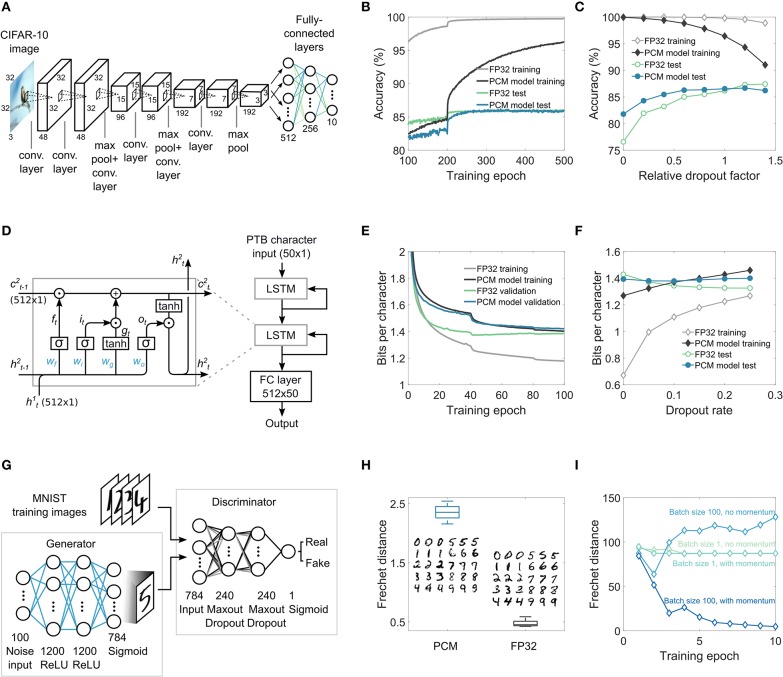
MCA training validation on complex networks. (A) Convolutional neural network for image classification on CIFAR-10 dataset used for MCA training simulations. The two convolution layers followed by maxpooling and dropout are repeated thrice, and are followed by three fully-connected layers. (B) The classification performance on the training and the test datasets during training. It can be seen that the test accuracy corresponding to MCA-based training eventually exceeds that from the high-precision (FP32) training. (C) The maximal training and test accuracies obtained as a function of the dropout rates. In the absence of dropout, MCA-based training significantly outperforms FP32-based training. (D) The LSTM network used for MCA training simulations. Two LSTM cells with 512 hidden units followed by a fully-connected (FC) layer are used. (E) The BPC as a function of the epoch number on training and validation sets shows that after 100 epochs, the validation BPC is comparable between the MCA and FP32 approaches. The network uses a dropout rate of 0.15 between non-recurring connections. (F) The best BPC obtained after training as a function of the dropout rate indicates that without any dropout, MCA-based training delivers better test performance (lower BPC) than FP32 training. (G) The GAN network used for MCA training simulations. The generator and discriminator networks are fully-connected. The discriminator and the generator are trained intermittently using real images from the MNIST dataset and the generated images from the generator. (H) The Frechet distance obtained from MCA training and the generated images are compared to that obtained from the FP32 training. (I) The performance measured in terms of the Frechet distance as a function of the number of epochs obtained for different mini-batch sizes and optimizers for FP32 training. To obtain convergence, mini-batch size >1 and the use of momentum are necessary in the training of the GAN.